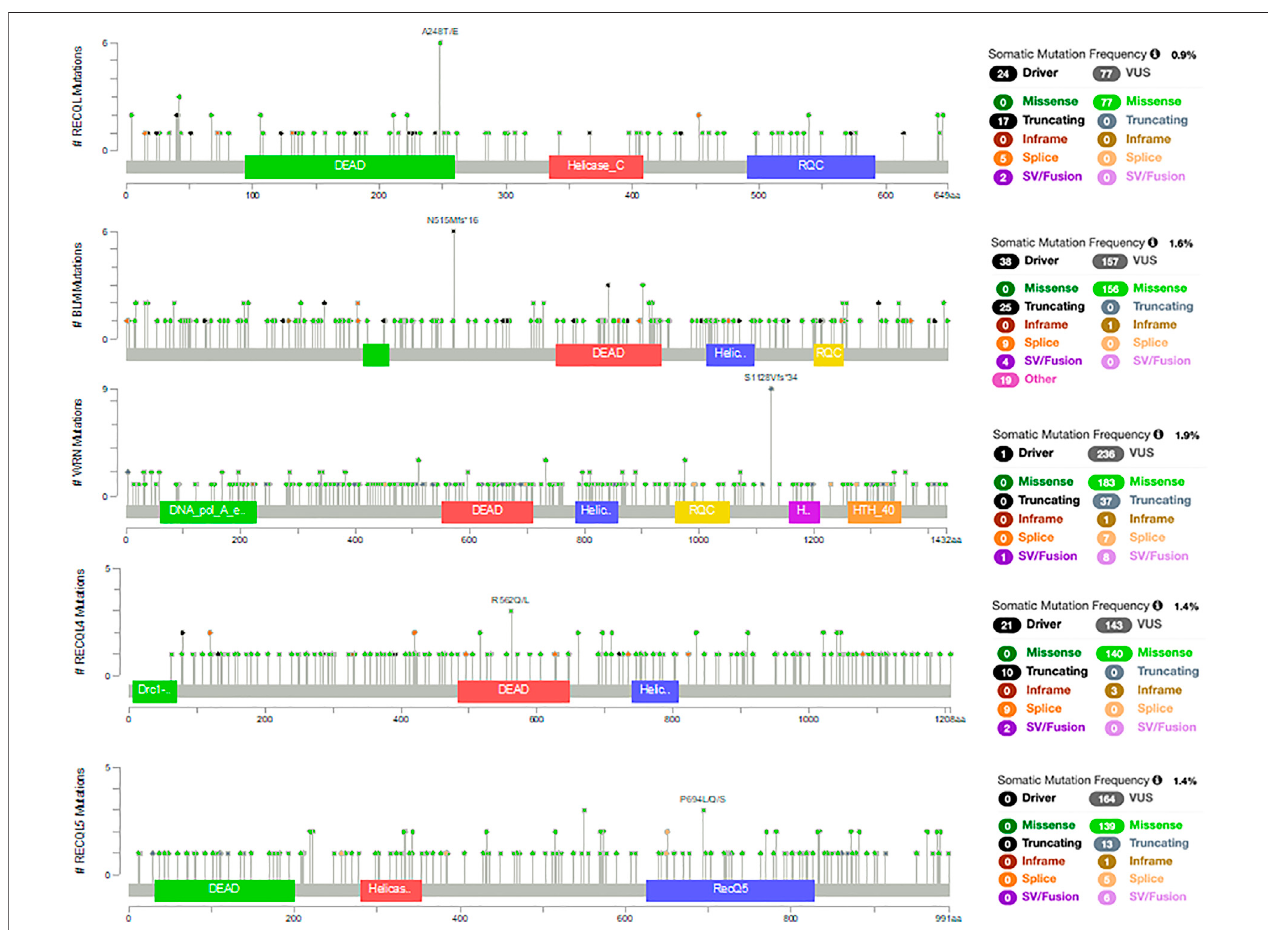
FIGURE 1 | Somatic mutations in RecQ helicases from the PanCancer Atlas with 10,967 samples of different cancer types (Cerami et al., 2012; Gao et al., 2013).